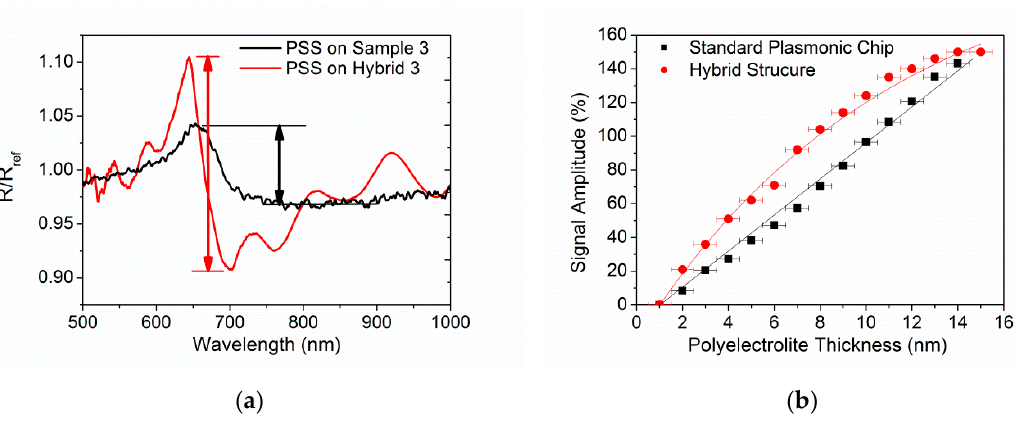
Figure 5. ( a ) Ratio between the reflectance spectra R and R ref acquired for Sample 3 and Hybrid 3 after the deposition of the first PSS and PDDA layer, respectively. The black and red arrow highlight the signal amplitude reported in ( b ) as a function of the polyelectrolyte thickness.